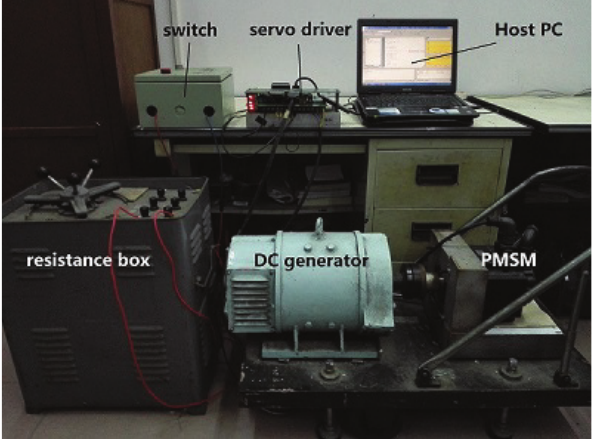
Figure 6. PMSM speed control experimental